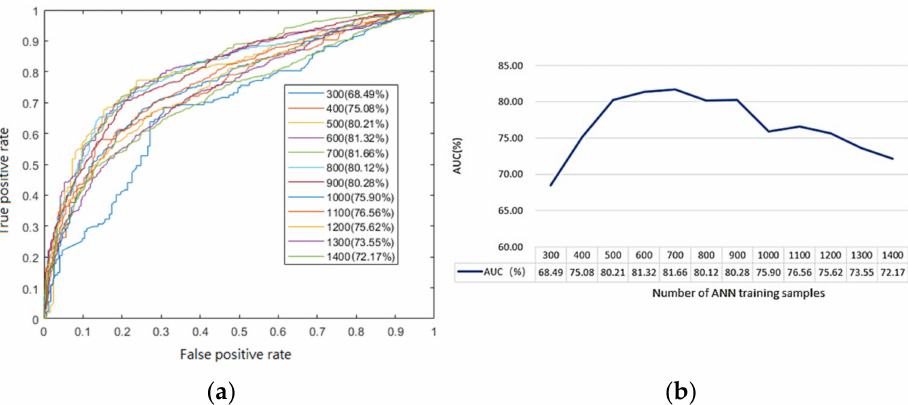
Figure 8. The value of the ANN model using different samples: ( a ) the ROC and AUC of ANN model using different samples; ( b ) the line chart of